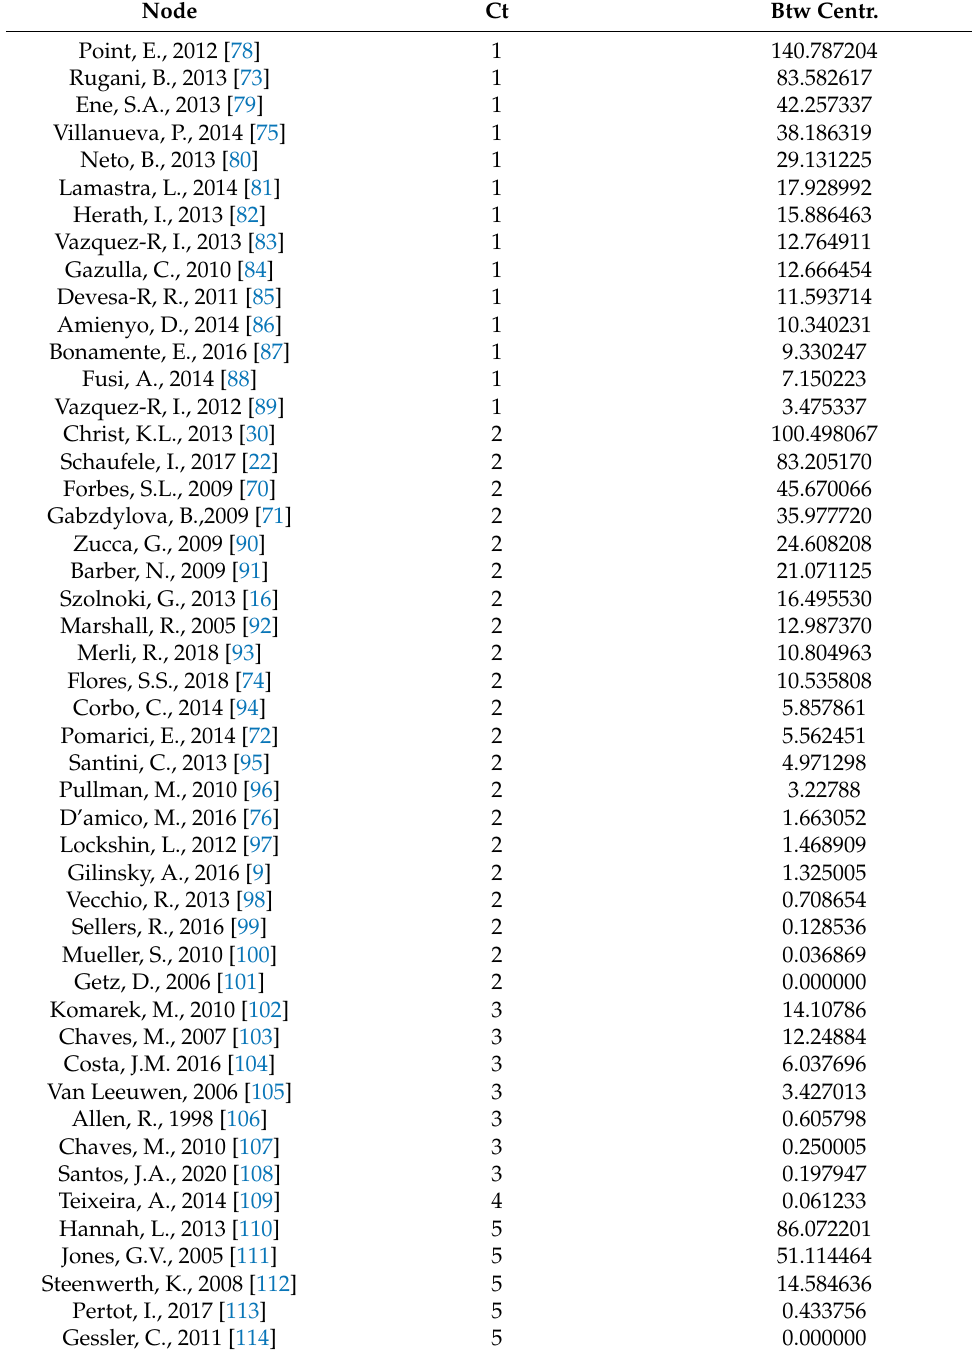
Table 11. Co-citation analysis of